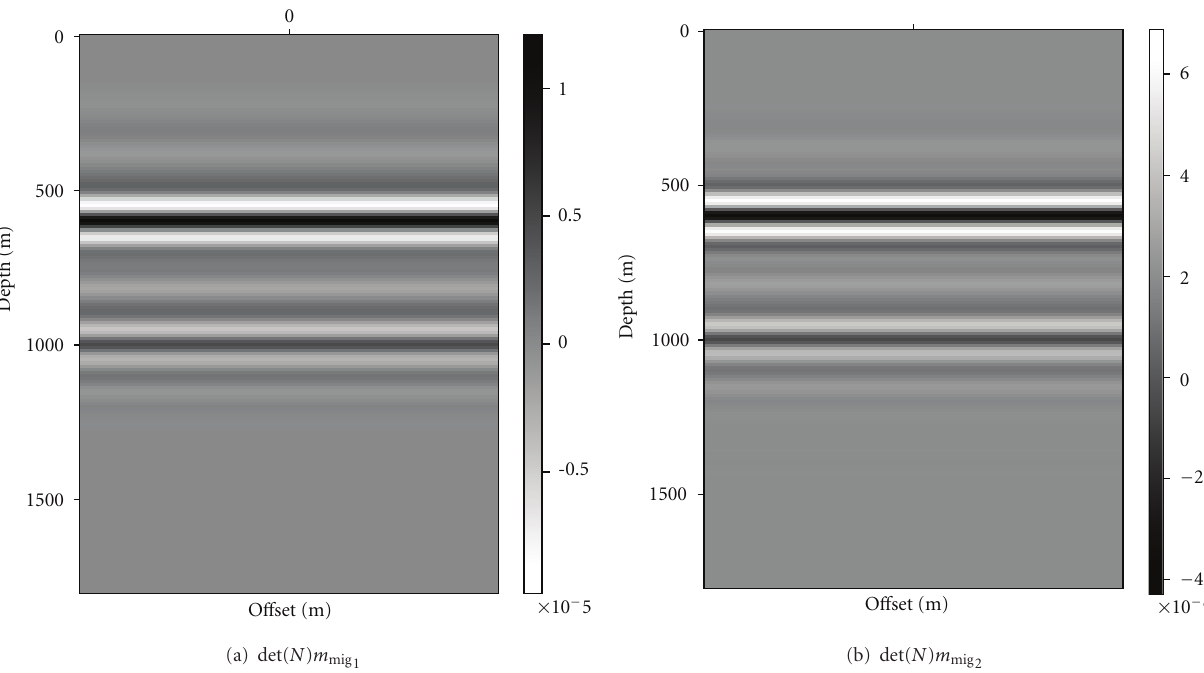
Figure 5: Scaling of the migrated images by det( N ), used to undo the determinant.